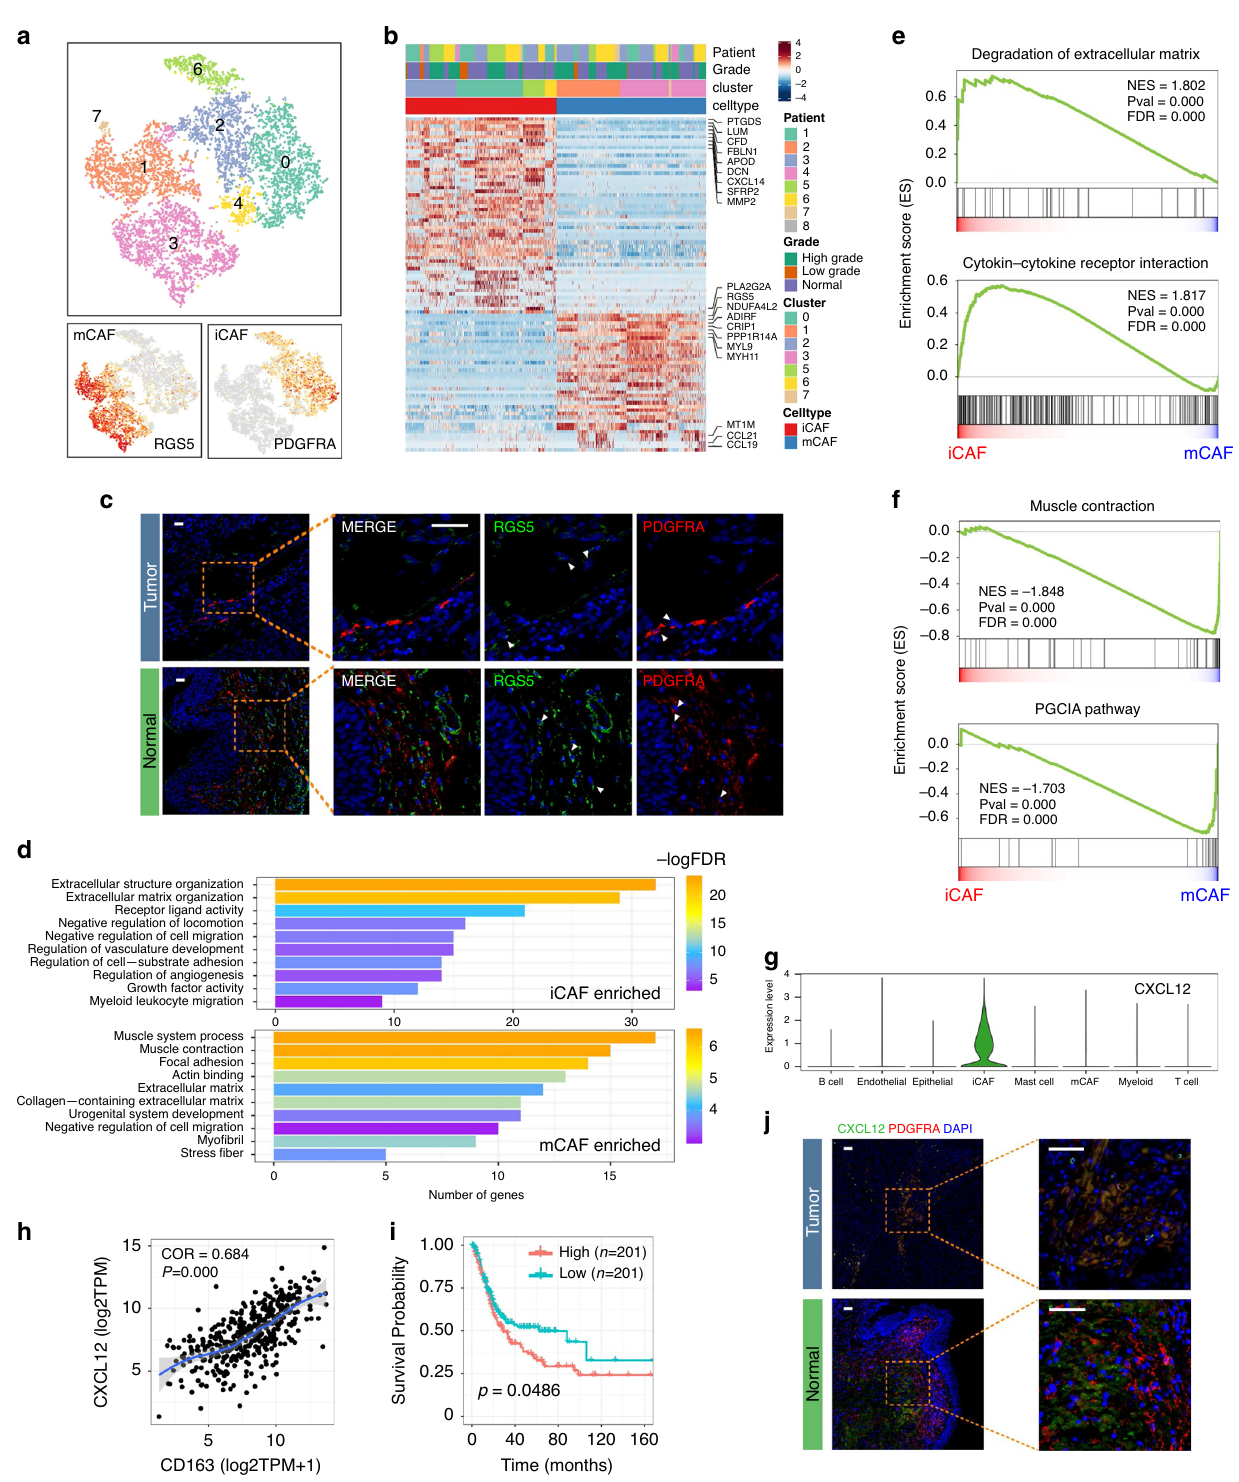
Fig. 3 Fibroblasts in BC could be divided into two different subgroups. a tSNE plot of fi broblasts colored by clusters (up) and subgroup markers (down). b Heatmap of DEGs between different fi broblast subgroups. c IF con fi rmed the existence of iCAFs and mCAFs ( n = 30). Scale bar represents 50 μ m. d Enriched GO functions of upregulated genes in iCAFs and mCAFs. e , f GSEA shows top enriched pathways in iCAFs (3E) and mCAFs (3F). NES denotes normalized enrichment score. g Violin plot shows expression level of CXCL12 across major cell types. h Correlation between CXCL12 level and tumor- in fi ltrated macrophages in TCGA BLCA cohort. Coef fi cient was calculated with spearman correlation analysis. i High level of CXCL12 predicted poor prognosis in TCGA BLCA cohort. Log-rank p value < 0.05 was considered as statistically signi fi cant. j IF recognized CXCL12 + iCAFs in BC tissues. iCAFs are the major derivation of CXCL12 in tumor tissues. Scale bar represents 50 μ